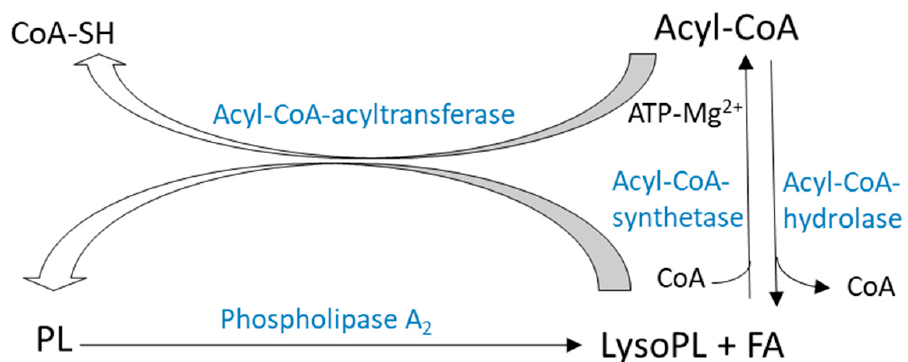
Figure 5. De-acylation/re-acylation cycle (Lands pathway) [31]. Lands pathway is a phospholipid remodeling mechanism through the de-acylation/re-acylation cycle where Lyso-PL is produced from PL through PLA 2 action or from acyl-CoA through acyl-CoA-hydrolase’s action. Lyso-PL with the action of acyl-CoA-acyltransferase and in the presence of FA leads to PL production. (Copyright © 2022,